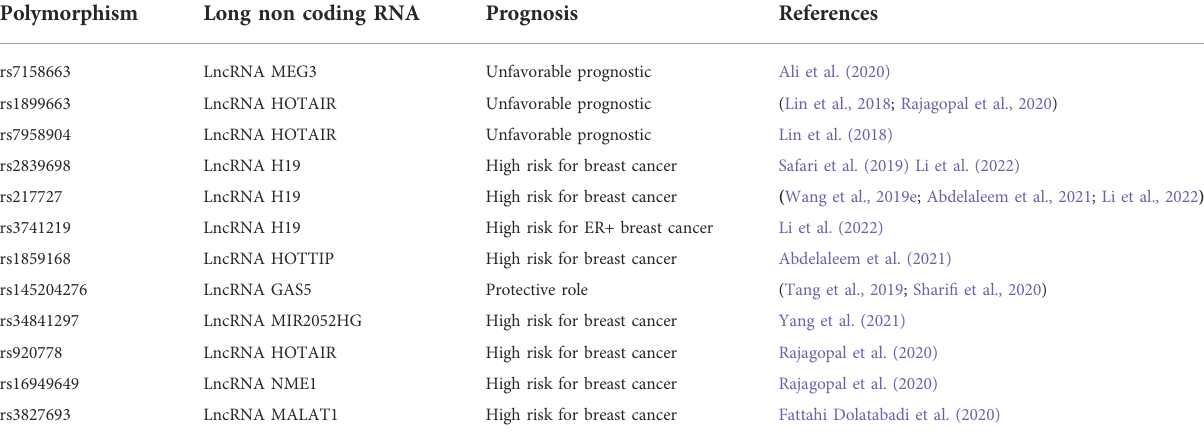
TABLE 1 Polymorphism in long noncoding RNA gene and association with breast cancer